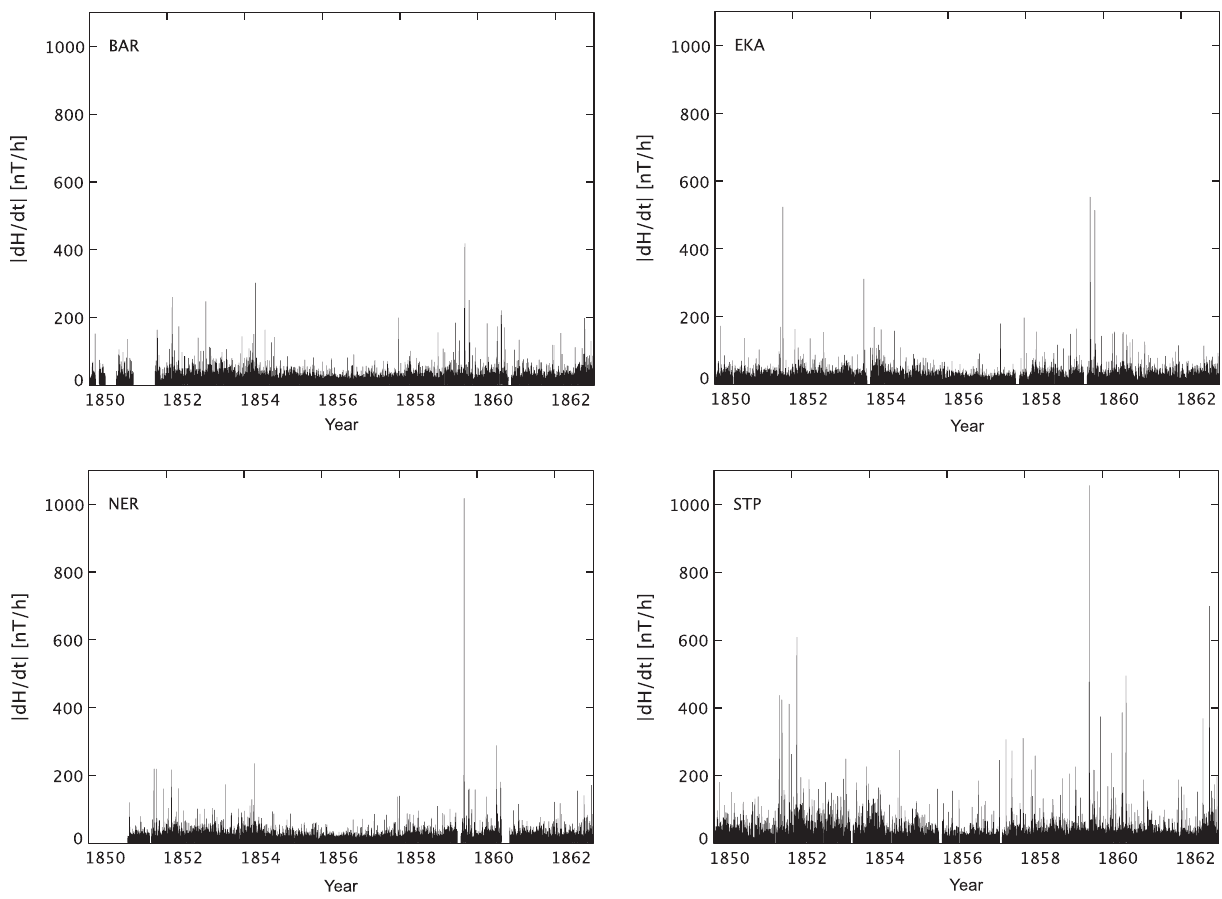
Fig. 8. All values of |d H /d t | at BAR, EKA, NER and STP in 1850–1862 for 1-h spot readings.